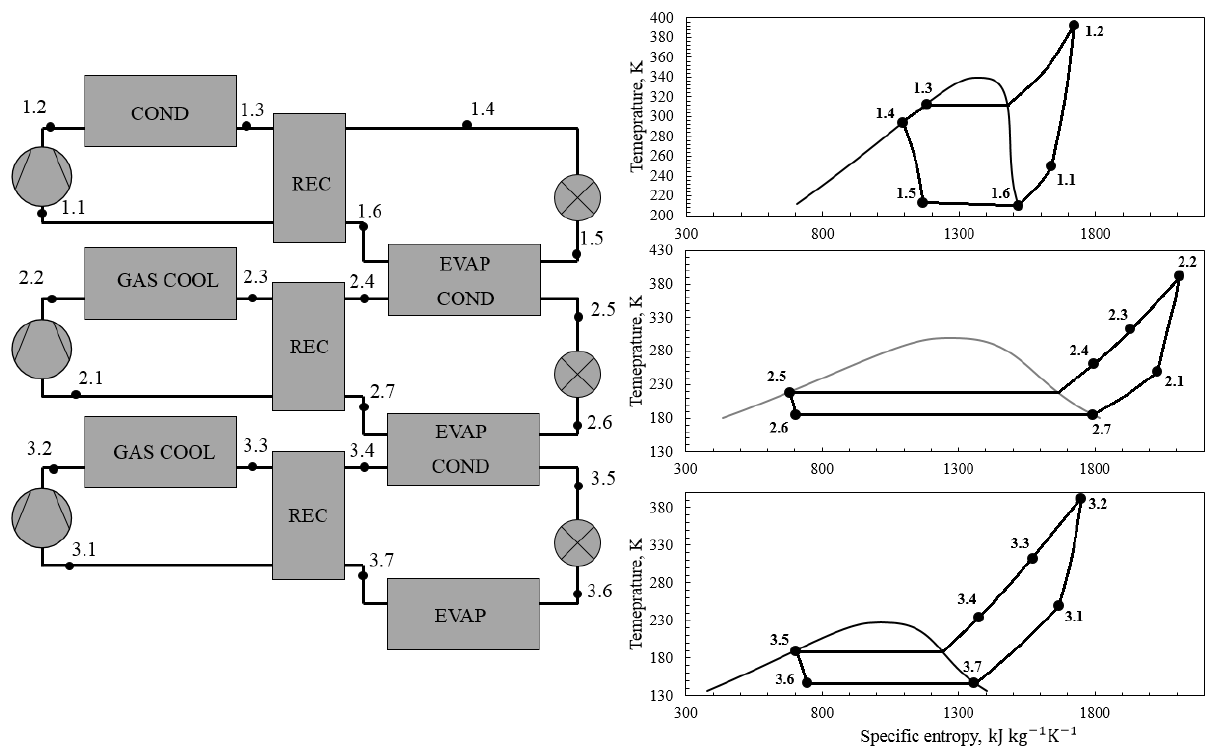
Figure 3. The scheme of the three-stage cascaded refrigeration system with single-stage